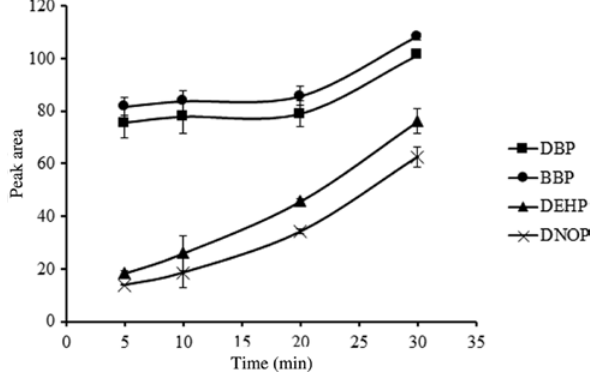
Figure 6: The effects of extraction time on the PE extraction efficiency. (Amount of Fe solvent = methanol; desorption time = 1 min).